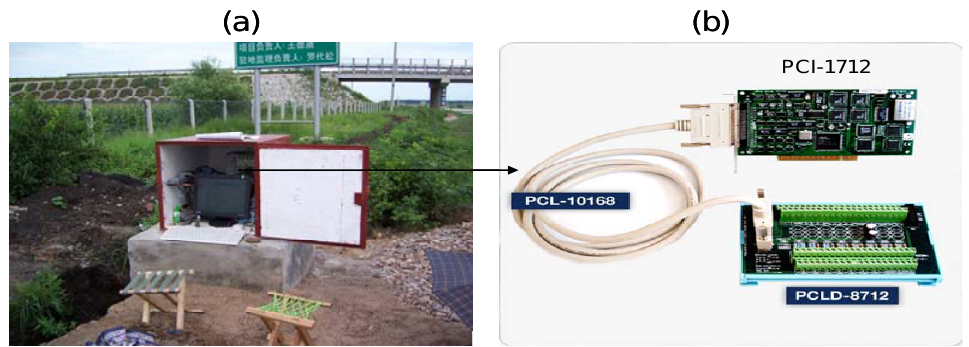
Figure 2 . Photos of: (a) the data collection device (b) the data collection card and interface